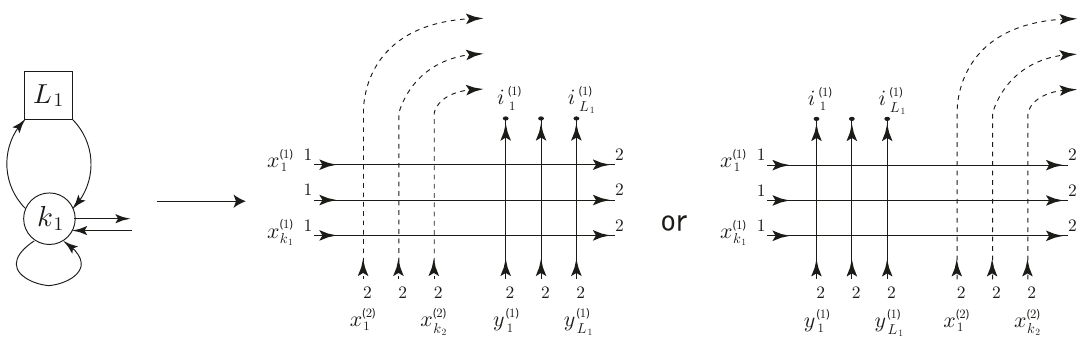
Figure 12 . Two possible lattice configurations that can be associated with the first quiver node.